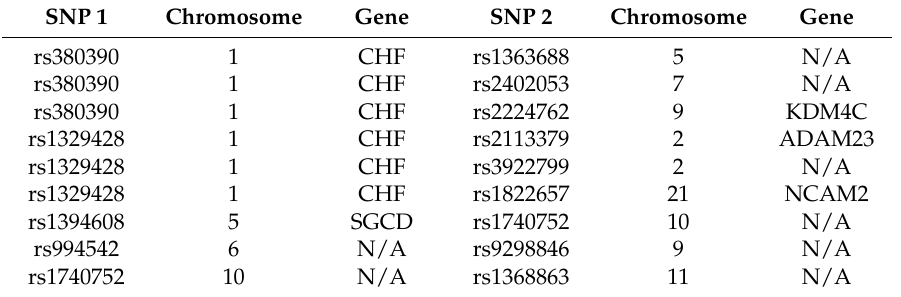
Table 9. Experimental results of age-related macular degeneration (AMD) data identified by IEACO. SNP 1 Chromosome Gene SNP